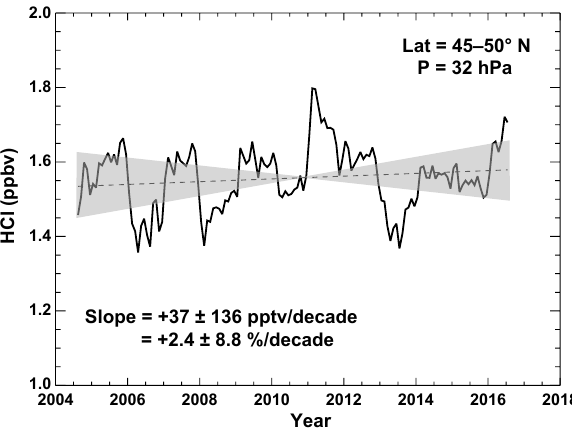
Figure 2. Deseasonalized monthly-mean MLS measurements of HCl concentration at 32hPa. Measurements are area-weighted be- tween 45 and 50 ◦ N. The dashed line is a linear least squares fit to the data, and the shaded area indicates the 2 σ uncertainty in that fit including consideration of autocorrelation in the time